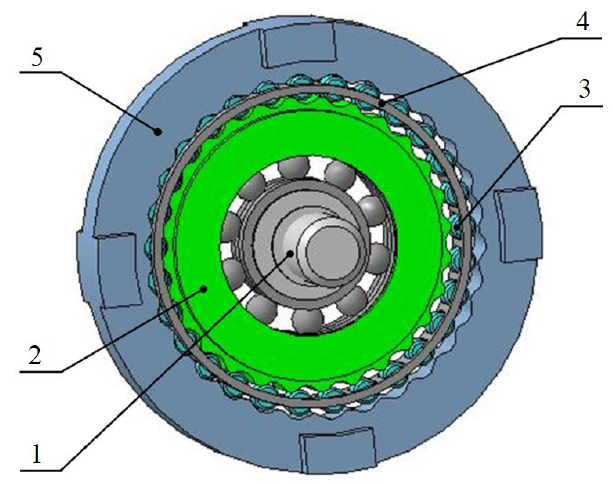
Figure 1. Diagram of the transmission with intermediate rolling elements and a free cage. The transmission with IREFC has two toothings: rolling elements and a cam (Figure 2a); rolling elements and a crown (Figure 2b) [26].